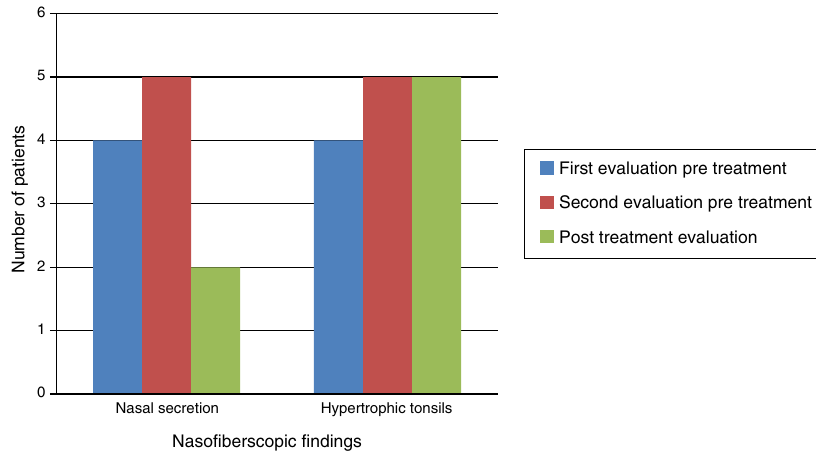
Figure 3 Major findings at the naso-fiberoscopy